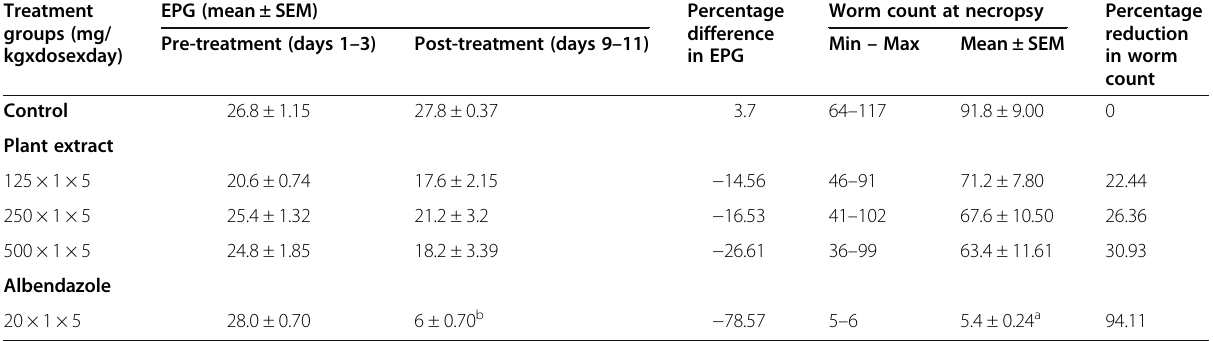
Table 2 In vivo anthelmintic effects of A. racemosus root extract* on S. obvelata infections in mice ( n = 5) Treatment groups